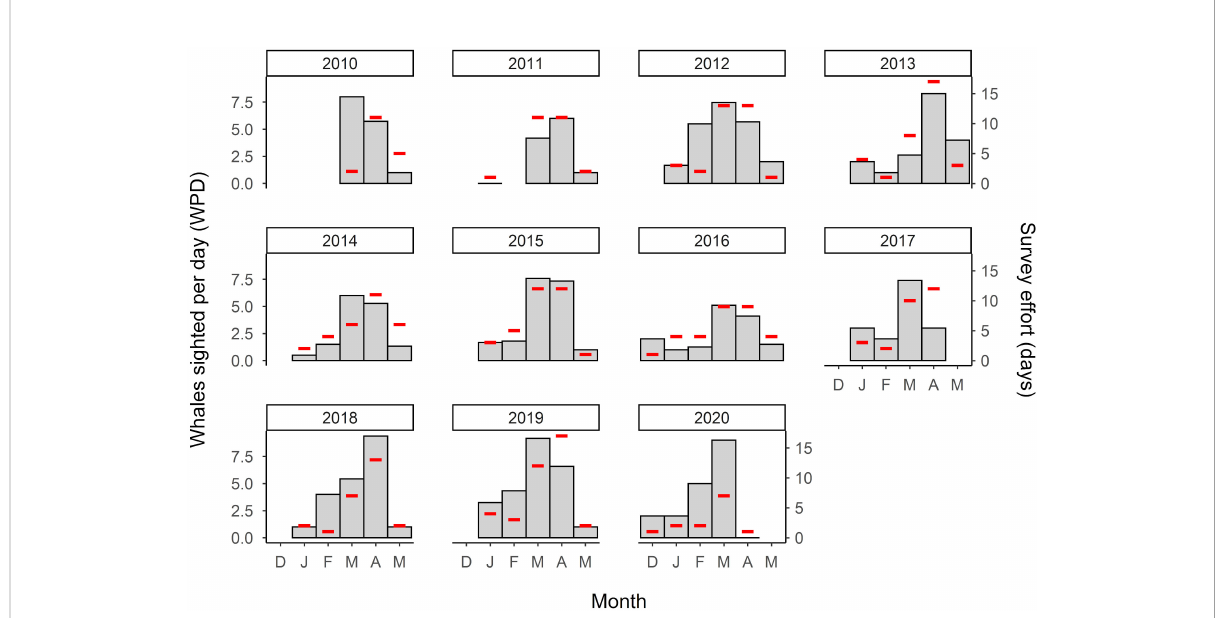
FIGURE 2 Whales sighted per day (WPD; gray bars, left-hand y-axis) and number of days of survey effort (red lines, right-hand y-axis) for each survey month and